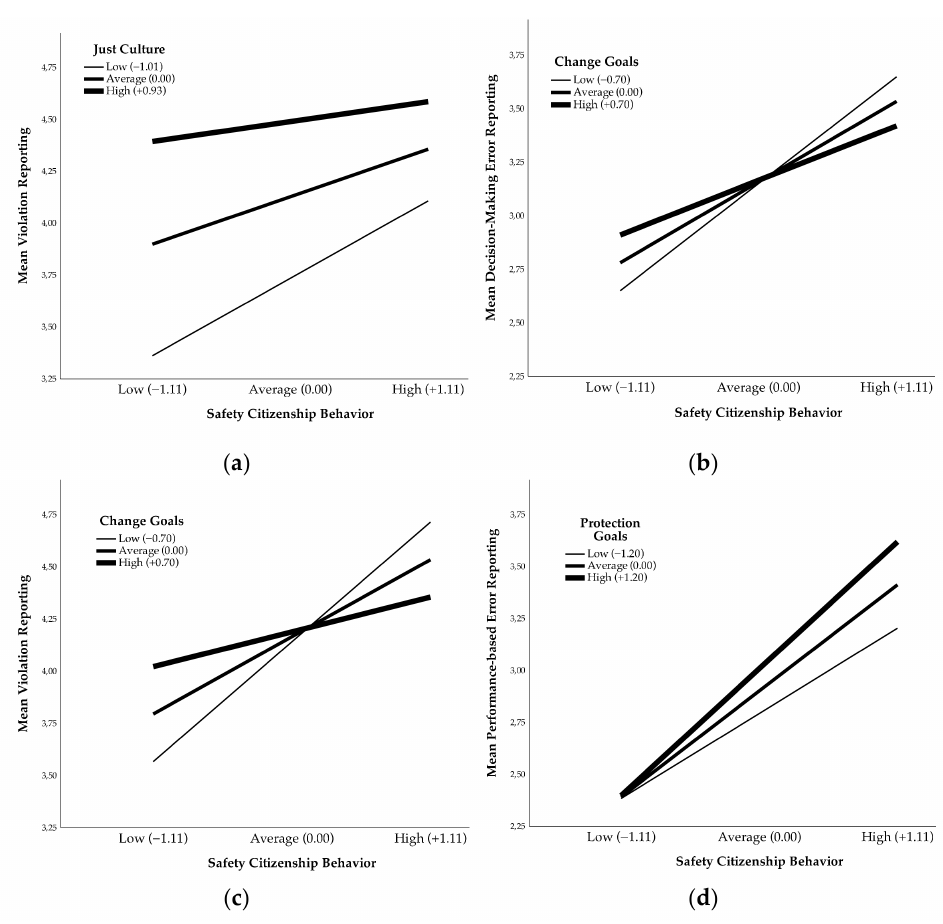
Figure 5. Moderation effect slopes for mean and ± 1 SD values: ( a ) effect of SCB on violation reporting moderated by just culture; ( b ) effect of SCB on decision-making error reporting moderated by change goals; ( c ) effect of SCB on violation reporting moderated by change goals; ( d ) effect of SCB on performance-based error reporting moderated by protection